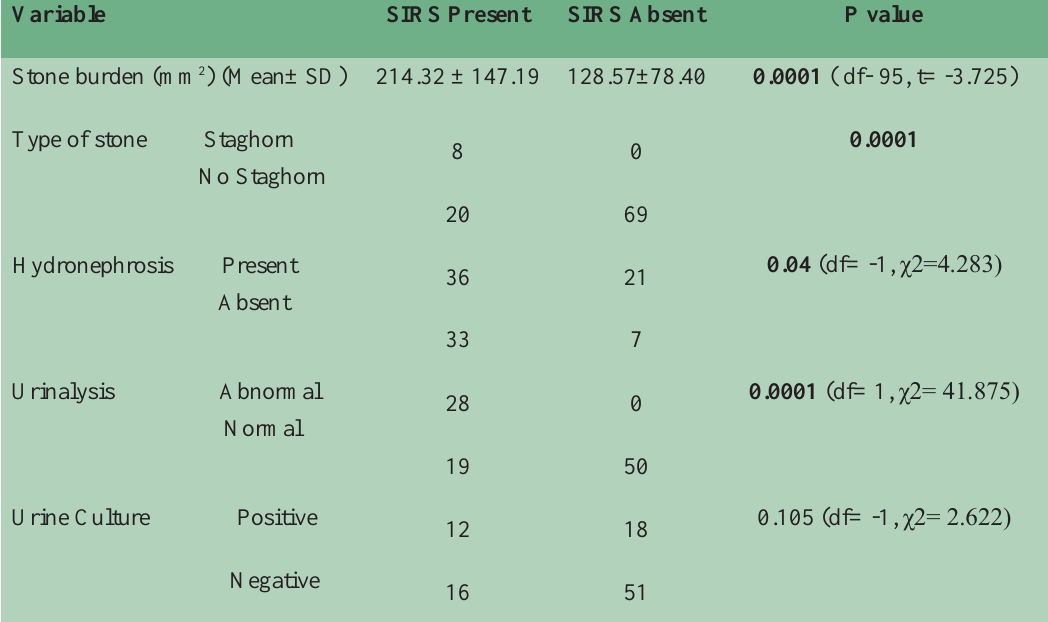
Table 1: Pre-operative parameters in relation to SIRS (N=97) Variable